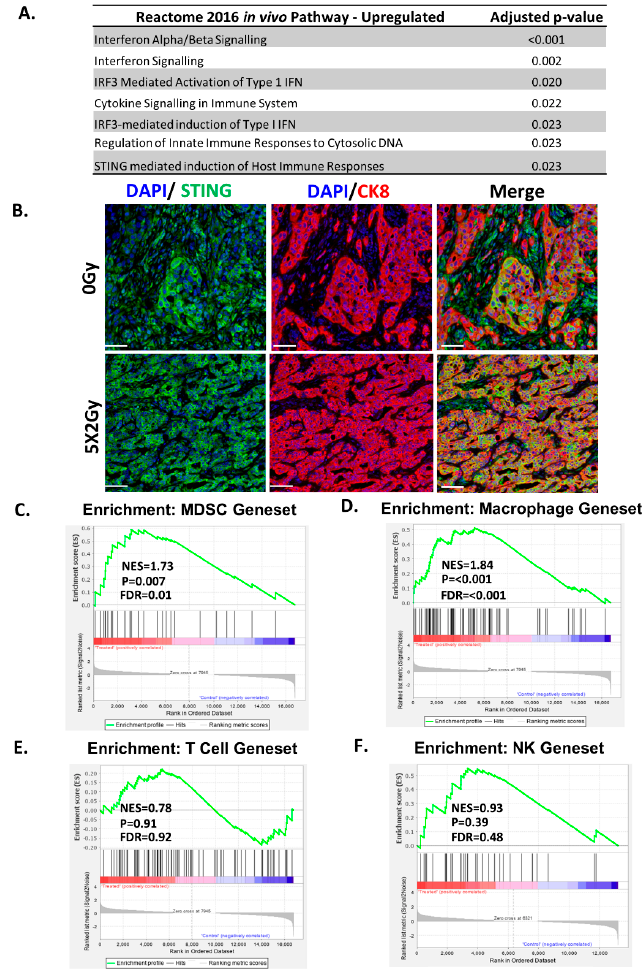
Figure 4. DVL3 immunosuppressive microenvironment enhanced by radiotherapy treatment. ( A ) Pathway enrichment analysis was performed using the online software Enricher for differential gene